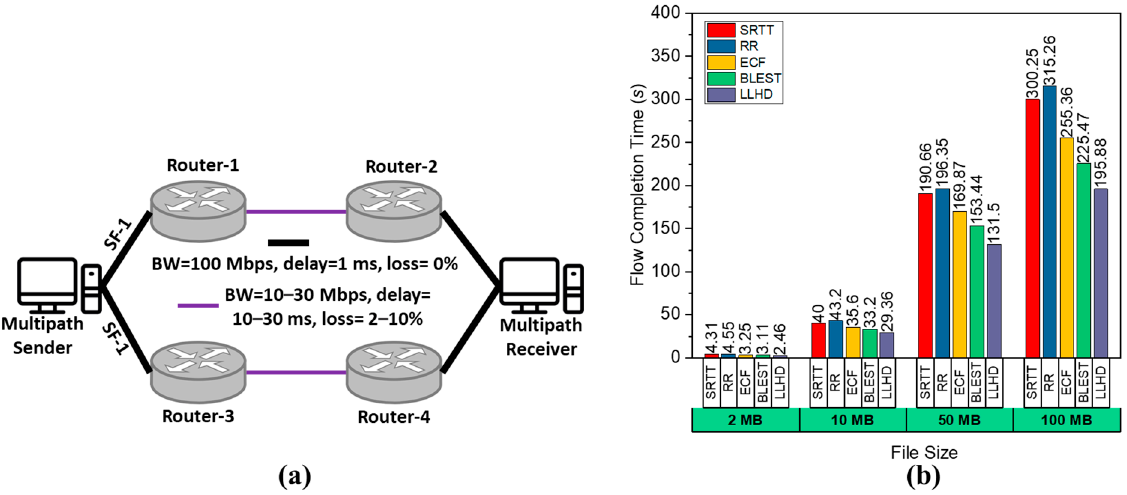
Figure 5. Performance evaluation of the considered schedulers in terms of FCT for a comprehensive scenario: ( a ) considered comprehensive scenario and ( b ) observed FCT. scenario: ( a ) considered comprehensive scenario and ( b ) observed